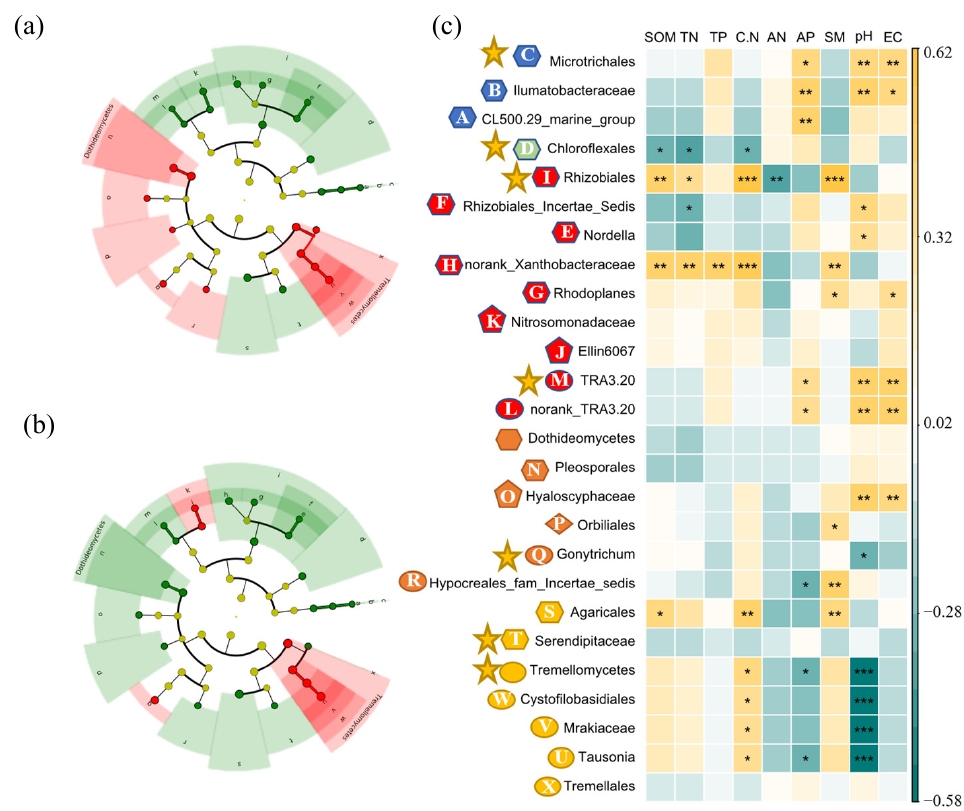
Figure 3. Mutual biomarkers of microbial lineages for bacteria and fungi were described from phylum to genus among farmland and gully at the Guangrong site (0–60 cm) and Yanmagou site in (0–20 cm) identified by linear discriminant analysis effect size (LEfSe), and their correlation with soil physicochemical properties. ( a , b ) are Cladograms of biomarkers in Guangrong and Yanmagou. The circle midpoints in cladograms represent the indicator of microbes with Linear discriminant analysis (LDA) score greater than 3, and the yellow dots represent the microbes without statistical difference between the farmland and gully. The green and red dots with radiation represent the biomarkers of the gully and farmland respectively. The Spearman correlation heatmap was used to analyze the relationship between soil physicochemical properties and biomarker microbes ( c ). The biomarkers with the same color diagram indicate the same phylum, and the same diagram shape indicates the same order. The key biomarkers are marked by the yellow star. * p < 0.05; ** p < 0.01; *** p < 0.001